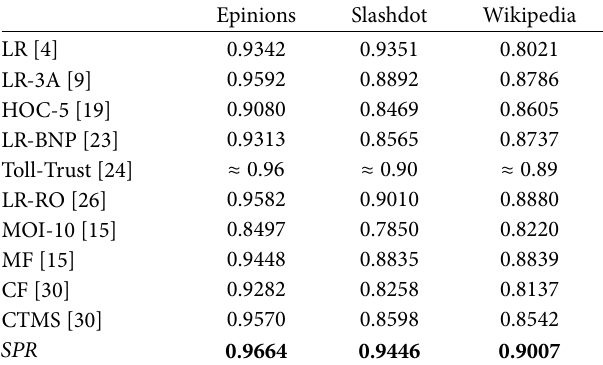
Table 5: The results of 𝑎𝑐𝑐 on three networks.